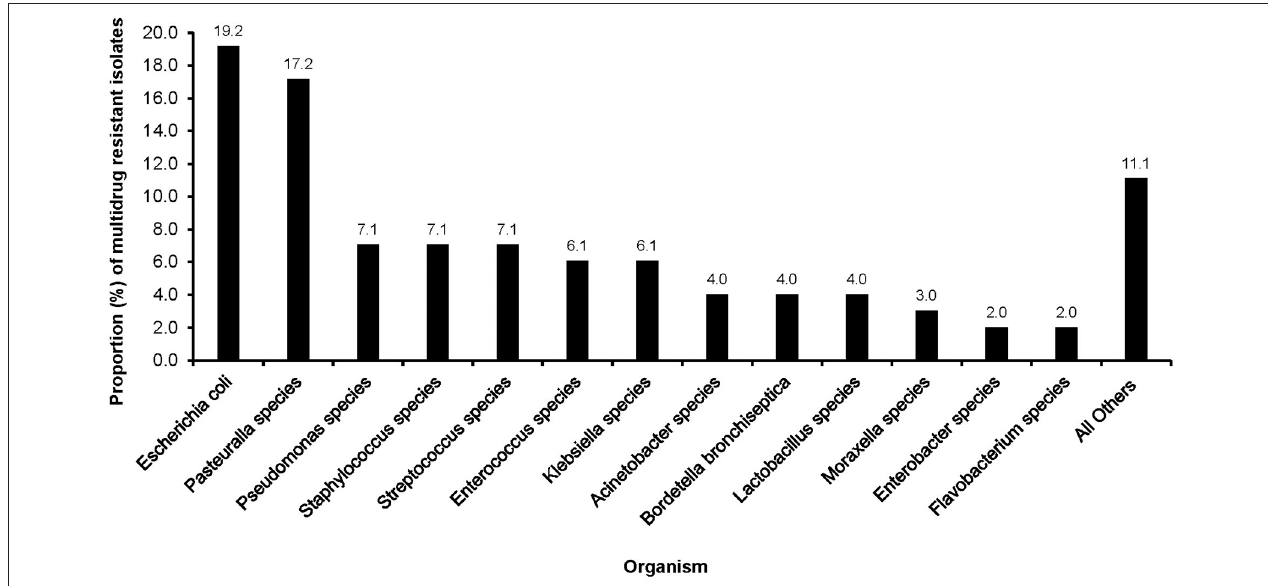
FIGURE 2 | Distribution of multidrug resistant organisms isolated from clinical samples of dogs presented at a referral veterinary teaching hospital in South Africa, 2007-2013.